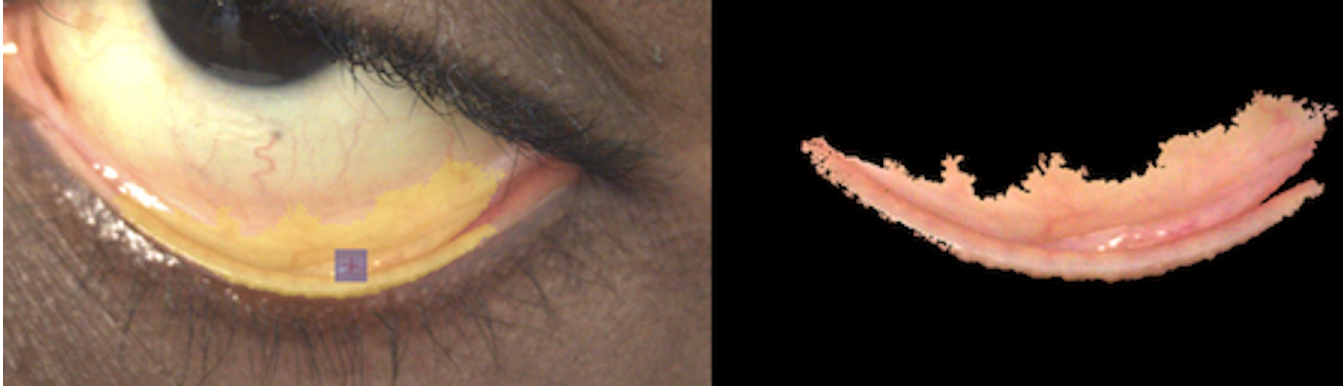
Fig 1. Image capture and region of interest selection. (A) Participant’s left eye in the MATLAB application for selection of conjunctiva region to be used in analysis. The gray square outlines the selected pixel representing best conjunctiva color. (B) Region of interest (ROI) of the patient’s palpebral conjunctiva that was selected by the ROI